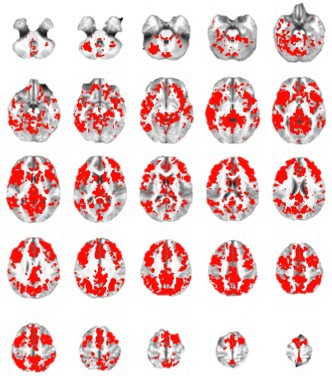
Increased fMRI connectivity during memory retrieval.Regions showing a significant main effect of demand independent from stimulation condition or stimulation group. All showed greater connectivity during the retrieval demand relative to rest. Left = Left. Red coloration indicates supra-threshold voxels with positive differences (retrieval > rest).